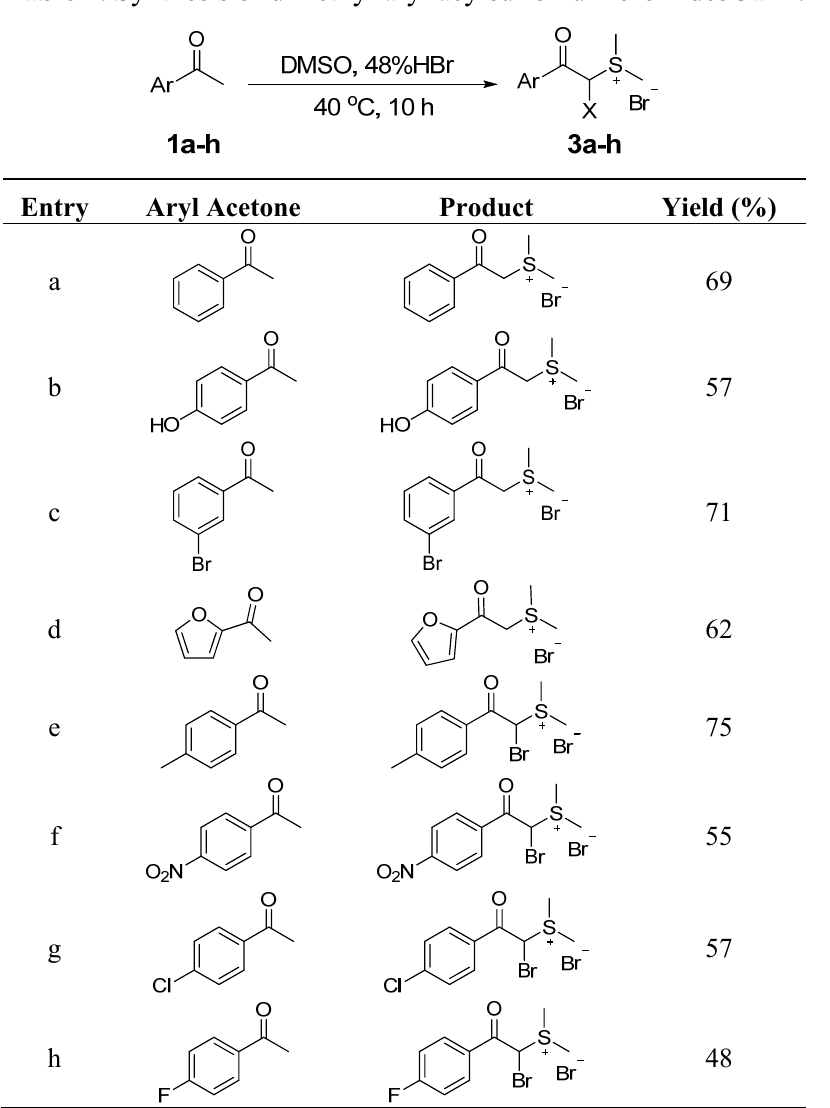
Table 1. Synthesis of dimethyl aryl acylsulfonium bromides 3a – h